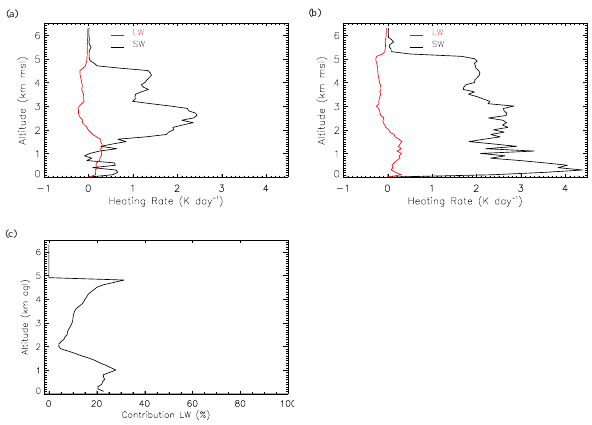
Fig.15. Heatingrateprofilesinthelongwavedomain(redsolidline)andintheshortwavedomain(blacksolidline)derivedfromLEANDRE 2at10 ◦ N (a) and13 ◦ N (b) withtheRaCHmodel. (c) Relativecontributionofthelongwavetothetotalheatingrateaveragedalongthe entireF/F20transecton14June. Fig. 15. Heating rate profiles in the longwave domain (red solid line) and in the shortwave domain (black solid line) derived from LEANDRE 2 at 10 ◦ N (a) and 13 ◦ N (b) with the RaCH model. (c) Relative contribution of the longwave to the total heating rate averaged along the entire F/F20 transect on 14